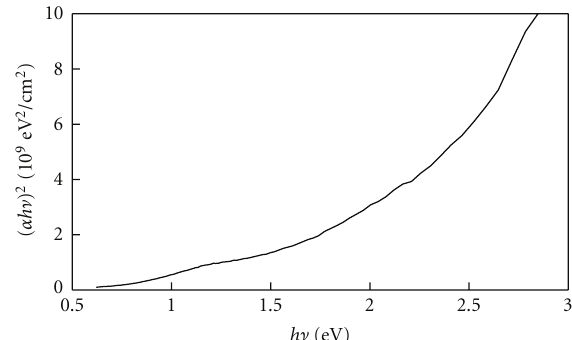
Figure 7: Plot of the absorption coe ffi cient for band gap estimation of the CTSO film deposited under condition 1.